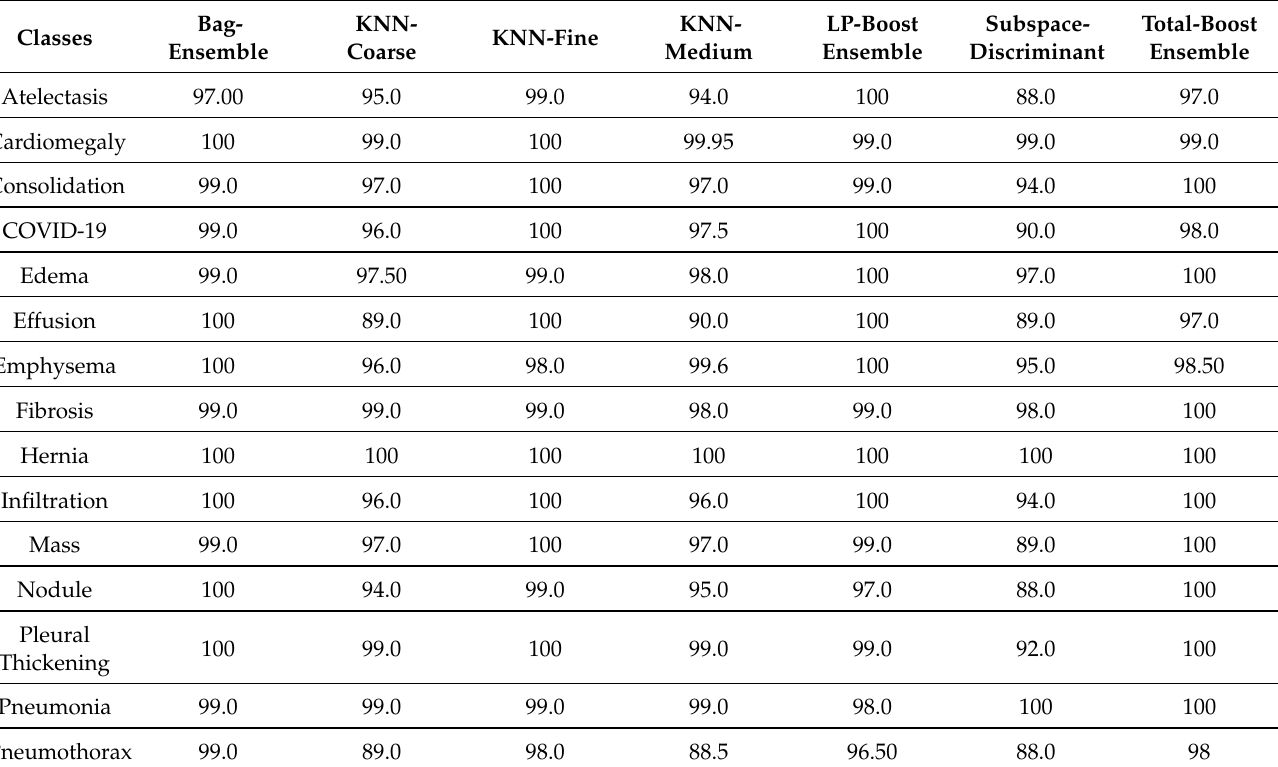
Table 8. Self-activated features based on classification using the fivefold technique results on individual class accuracy.